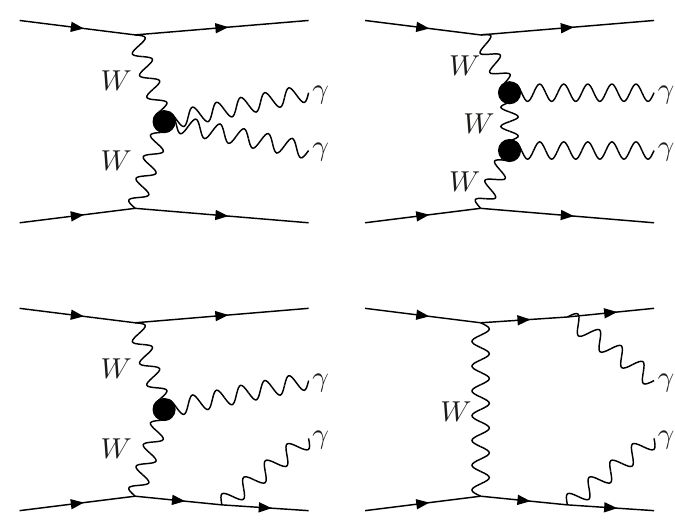
Figure 1 . Representative Feynman diagrams at LO. With dark dots, we highlight the sensitivity to electroweak triple and quartic gauge couplings of the